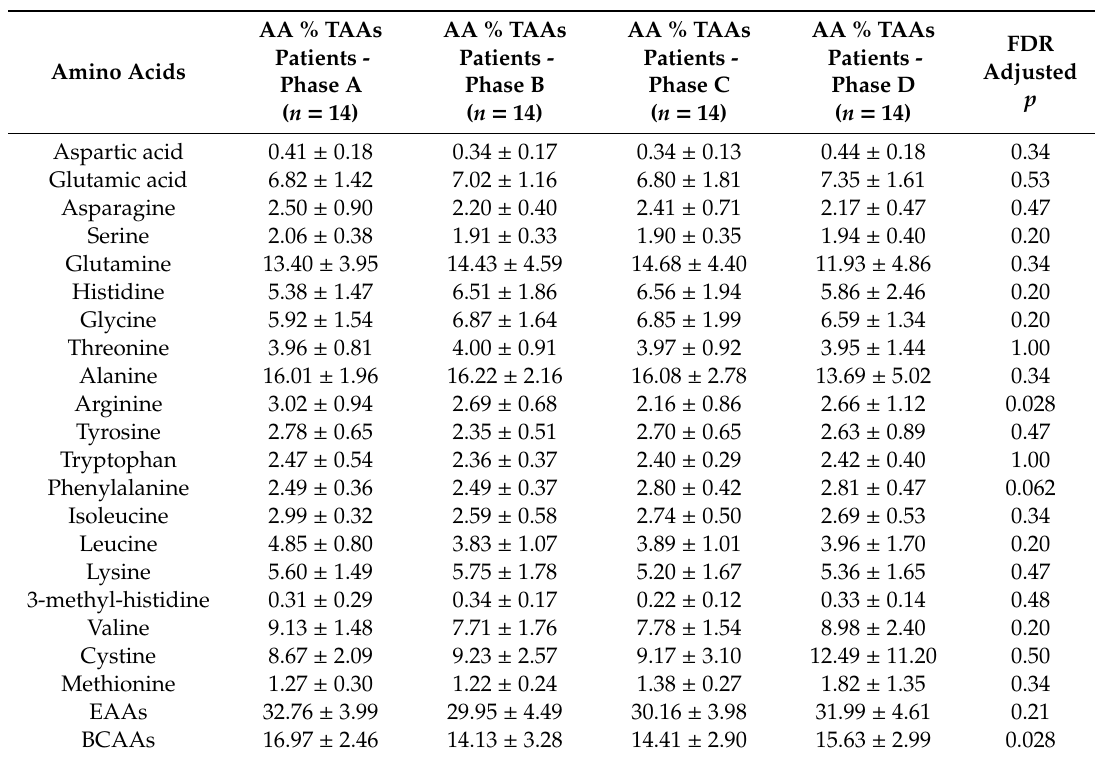
Table 4. Plasma amino acids expressed as a percentage (%) of total amino acids at each phase of chemotherapy (phase A = before; phase B = 1 month; phase C = 3 months and phase D = at the end of chemotherapy cycle—6 months).